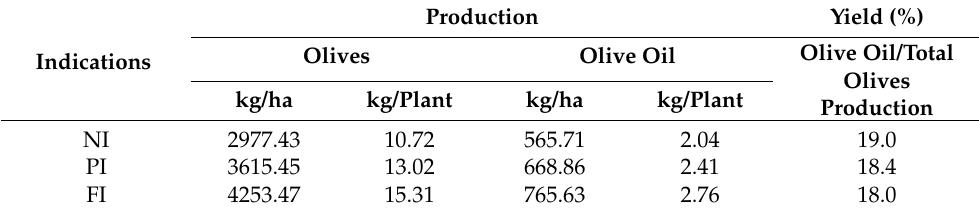
Table 4. Production of the olives and olive oil production in the farm examined.